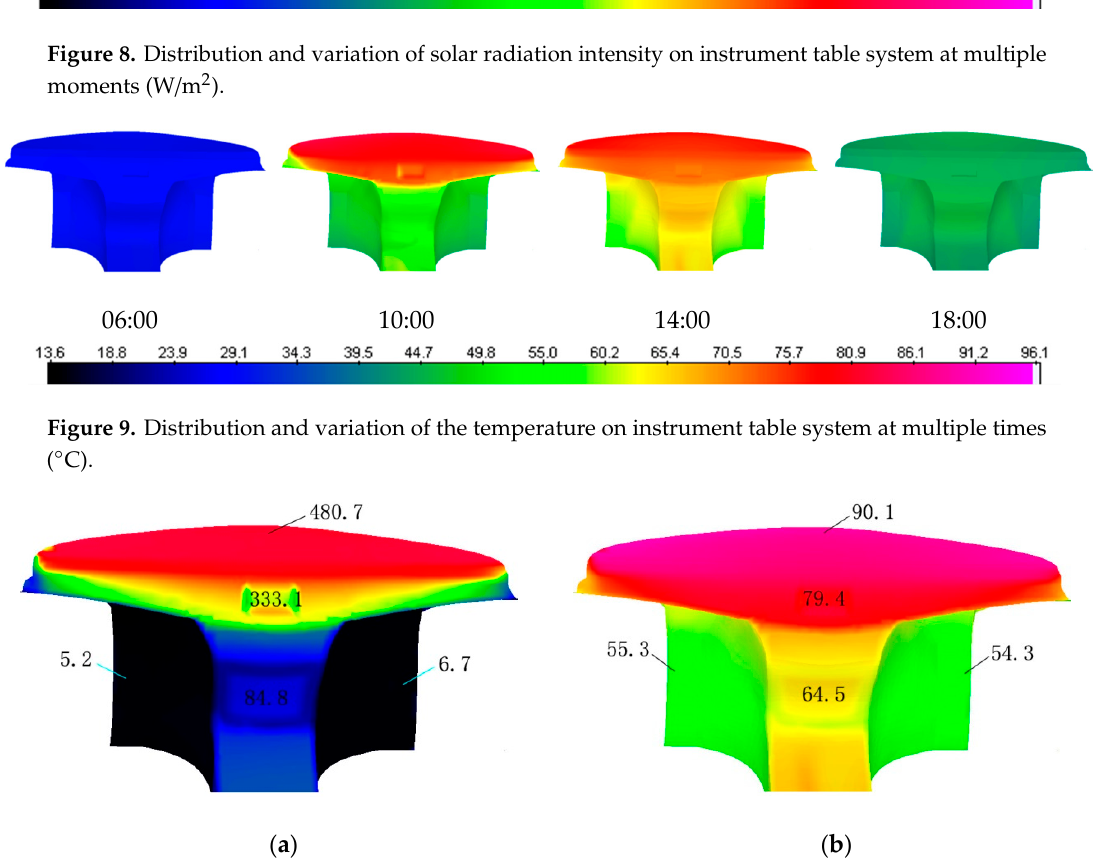
Figure 10. Non-uniform distribution of weathering external factors on instrument table at 12:00 a.m. on 25 June: ( a ) non-uniform distribution of solar radiation intensity (W/m 2 ); and ( b ) non-uniform distribution of temperature (°C).